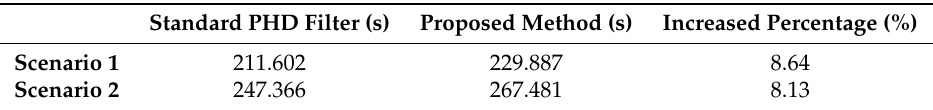
Table 1. Computing time of the standard PHD filter and the proposed